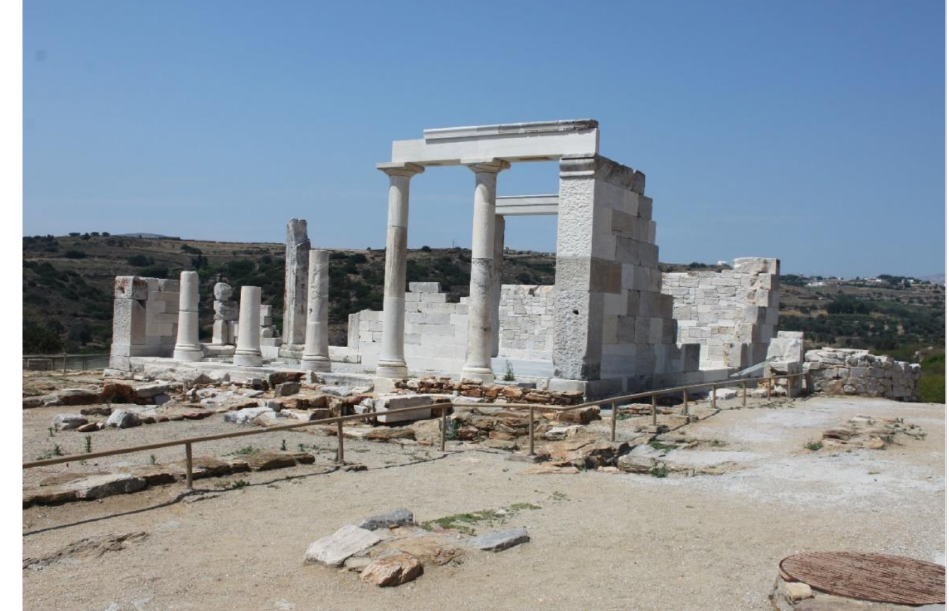
Figure 3. The Temple of Demeter on Naxos (© the